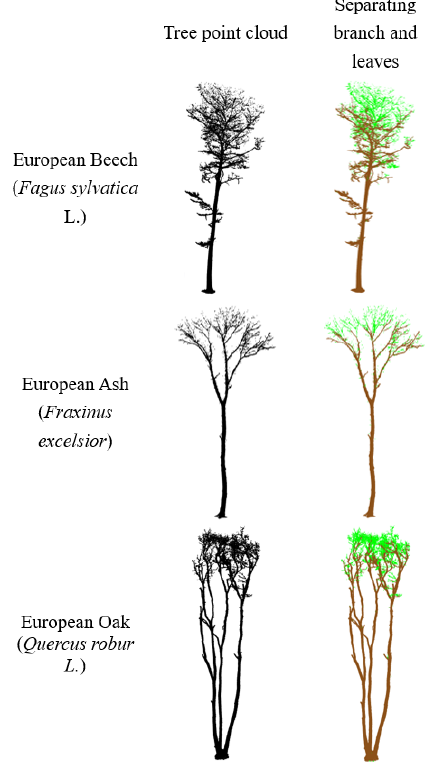
Figure 4. Public tree point